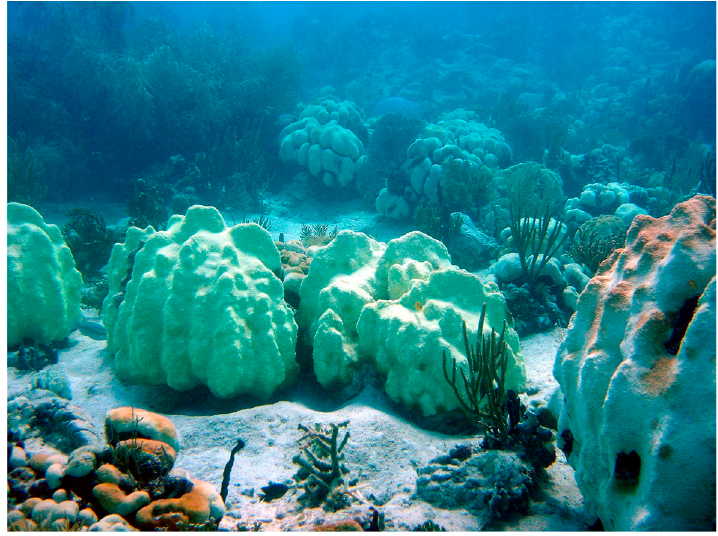
Figure 4. Extensive bleaching of Orbicella colonies off northwestern St. John in November 2005.